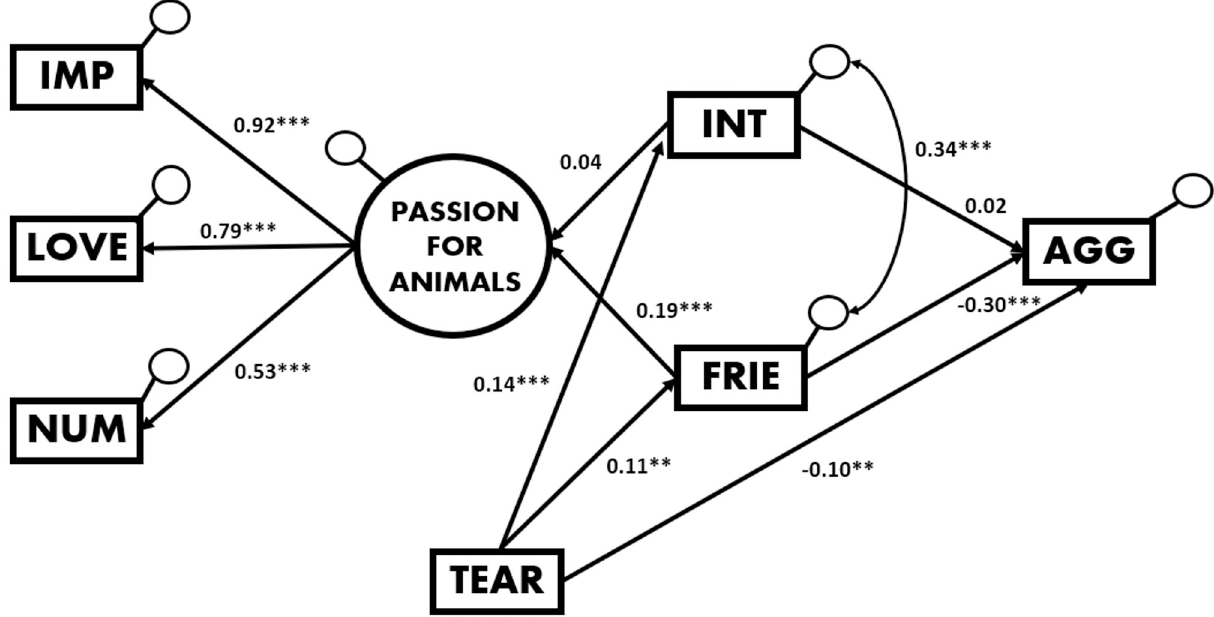
Fig 5. SEM of perception of aggressiveness with mediational effects. Standardized estimates with two-tailed p-values. The importance that animals have in our participant´s life (IMP), the love felt for them, and the number of animals with which participants have lived are indicators of the latent variable labelled “passion for animals”. This passion is significantly and positively influenced by the trend towards perceiving animals to be friendlier, while the presence of tears is a significant influence on the intensity, friendliness, and aggressiveness perceived. As illustrated, tears not only have a direct effect on the perception of aggressiveness, but also indirectly, through the friendliness perceived. CFI = 0.988, RMSEA = 0.04, SRMR = 0.02, χ 2 (9) = 20.39 with p < .05. � p < .05, �� p < .01, ��� p <